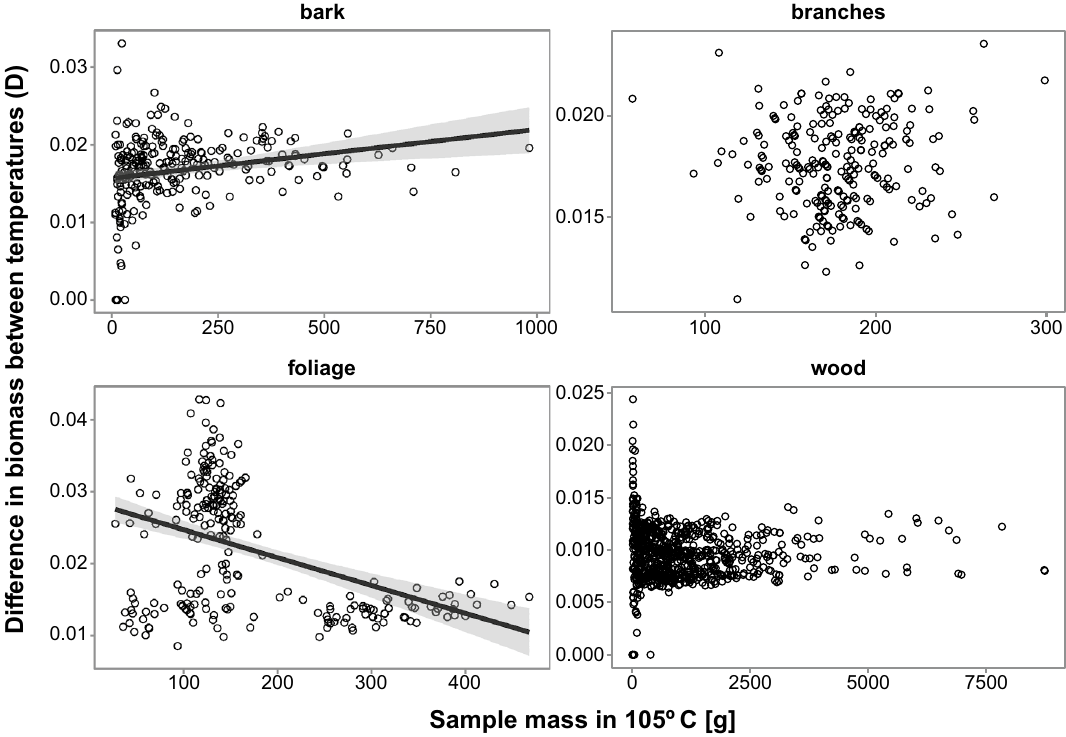
Figure 1. Relationships between sample mass (at 105 °C) and difference between drying temperatures (D) for biomass components (dimensionless). Regression lines were drawn for components with significant influence of sample mass (Table 2, S3). The plot has been generated using R software 38